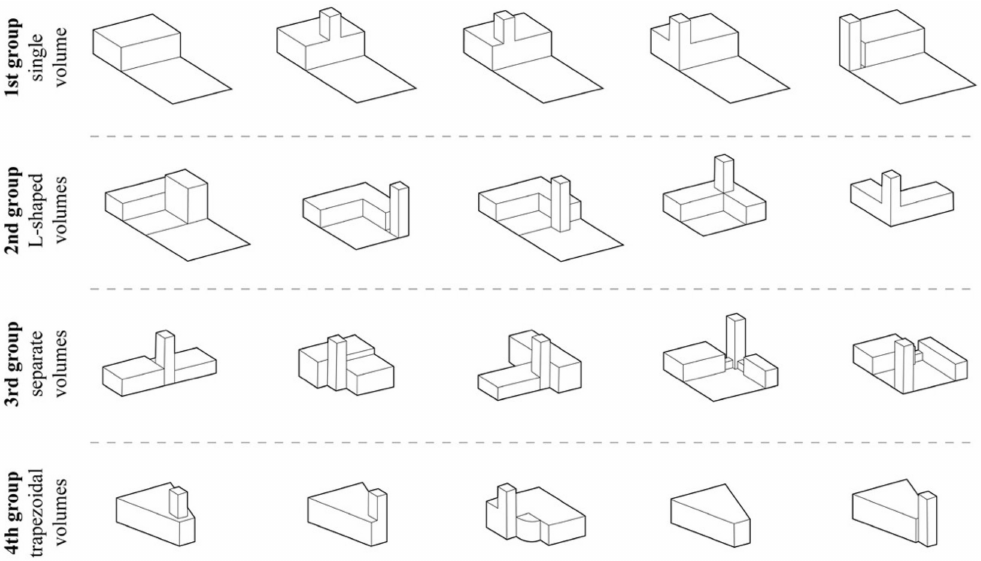
Figure 1. The four macro groups of architectural types.